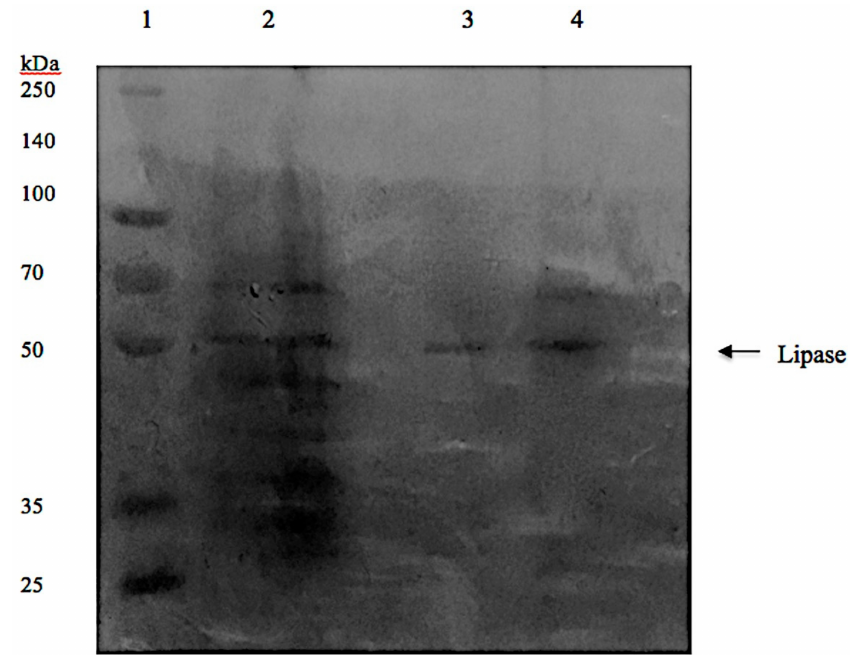
Figure 5. SDS-PAGE analysis of lipase recovered using Triton X-100/maltitol ATPS. The protein molecular weight of the standard protein markers ranged from 260 to 25 kDa. Lane 1: protein molecular markers, lane 2: crude feedstock, lane 3 and 4: ATPS top